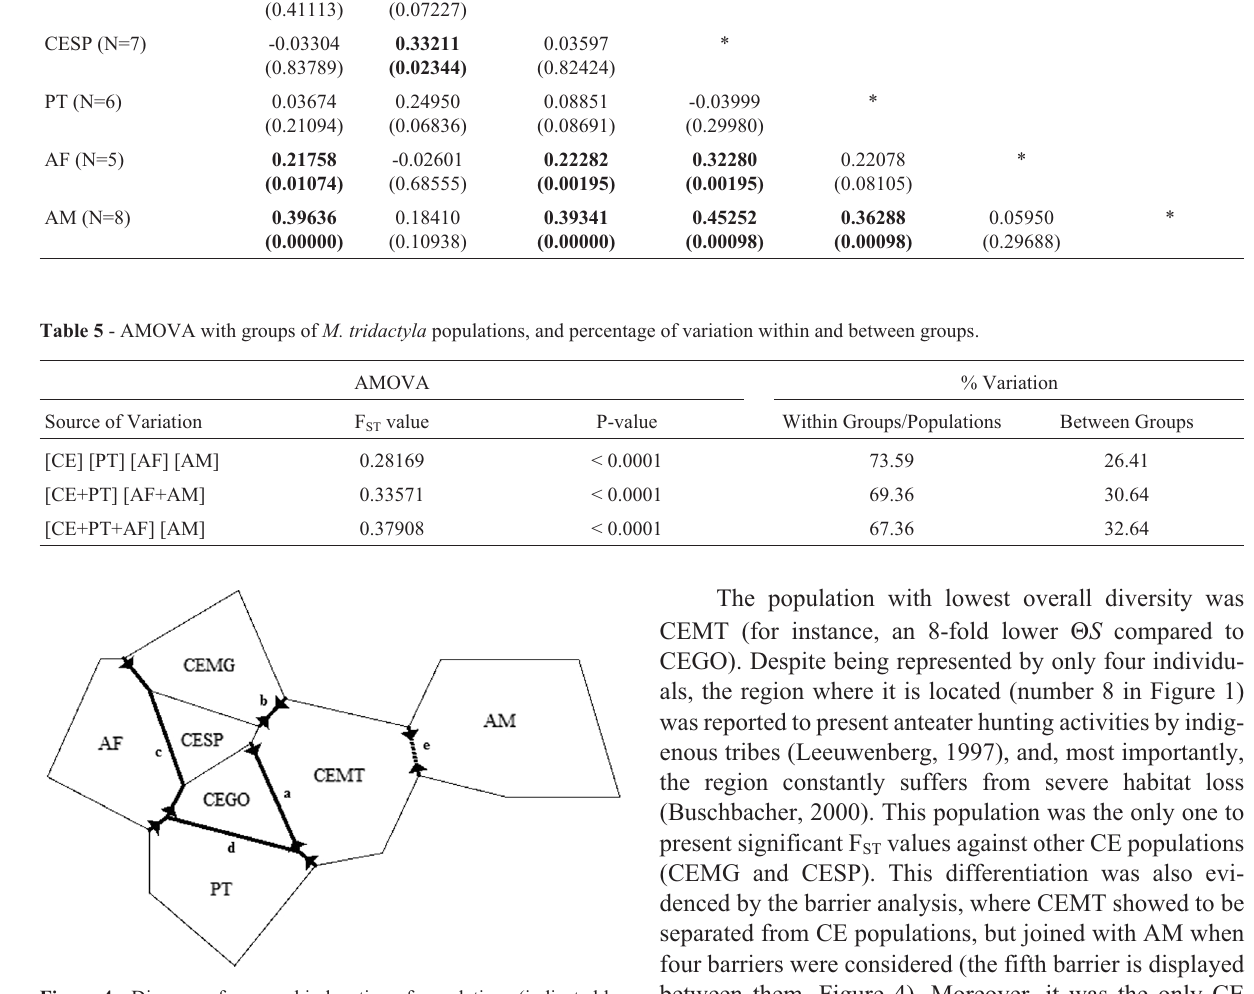
Figure 4 - Diagram of geographic location of populations (indicated by population codes) and the placement of genetic barriers detected. Solid boldlinesrepresentthefourbarriersrequestedtosoftwareBarrierv2.2( a , b , c and d ), and dashed bold line represent the extra barrier requested ( e